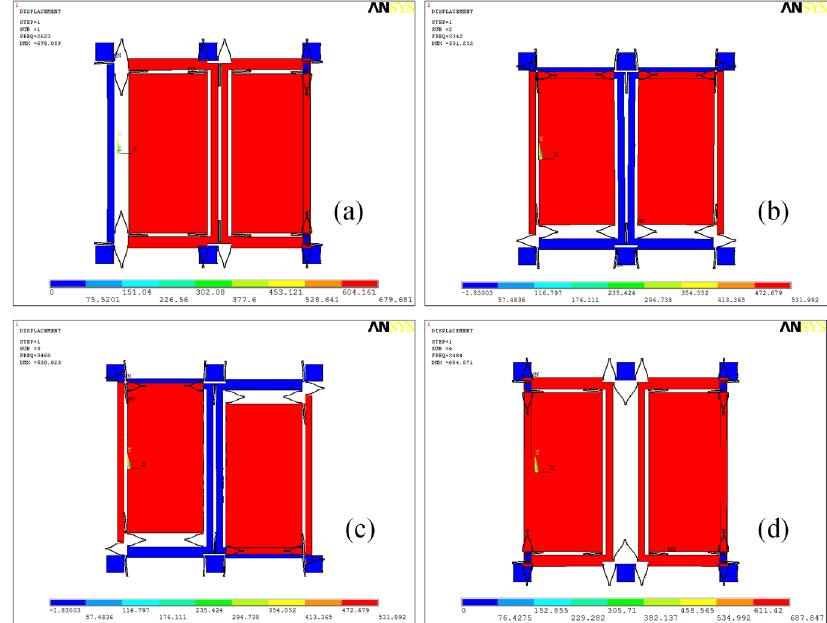
Figure 2. The first four order modes of dual-mass sensing mode-coupling micro-electro-mechanical system (MEMS) gyroscope structure: ( a ) drive in phase mode (first mode) with frequency ω x1 = 2623 × 2 rad/s; ( b ) sensing in phase mode (second mode) with frequency ω y1 = 3342 × 2 rad/s; ( c ) sensing anti-phase mode (third mode) with frequency ω y2 = 3468 × 2 rad/s; and ( d ) drive anti-phase mode (fourth mode) with frequency ω x2 = 3484 × 2 rad/s.